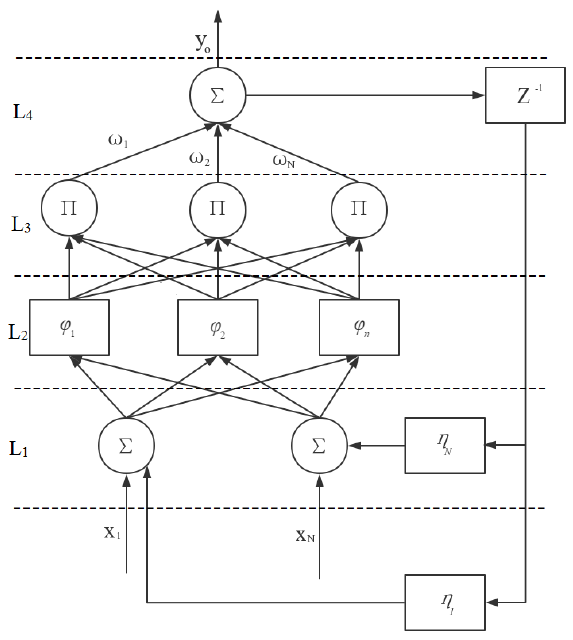
Figure 1: Structured flowchart of diagram of ORWNN neural